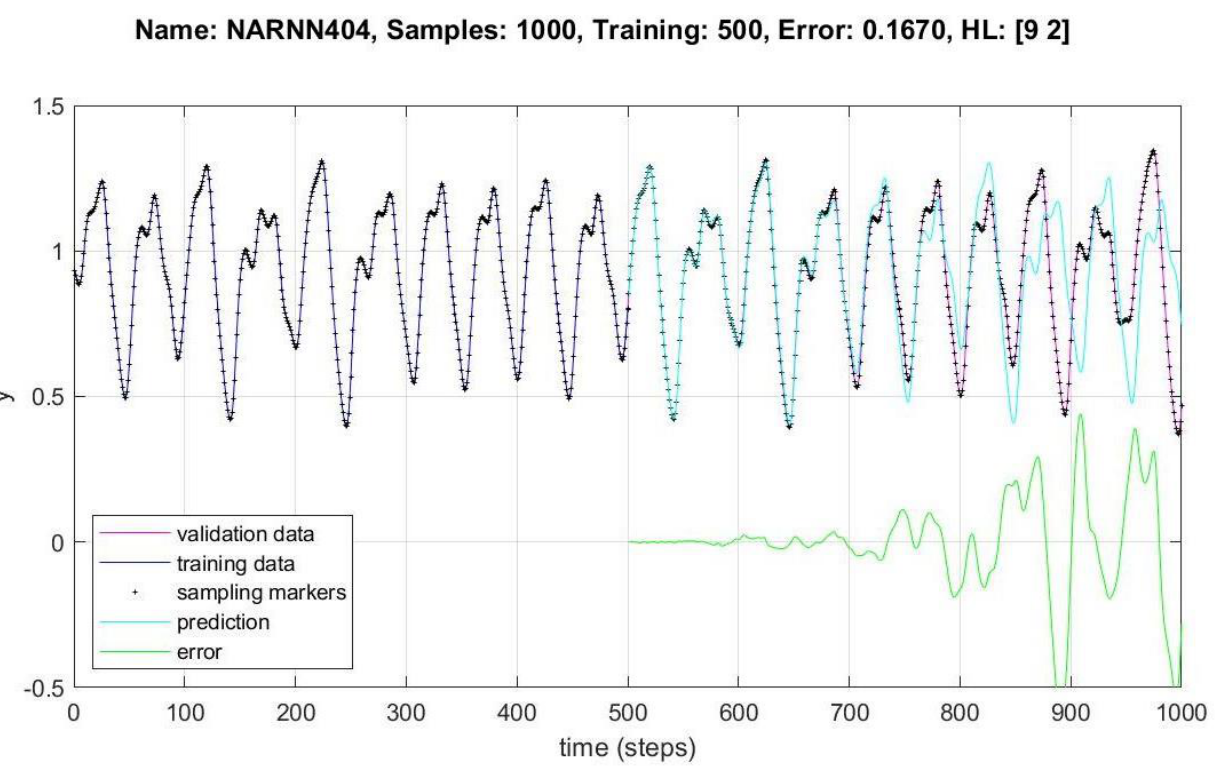
Figure 8. Performance of NARNN403 for 1000 samples.